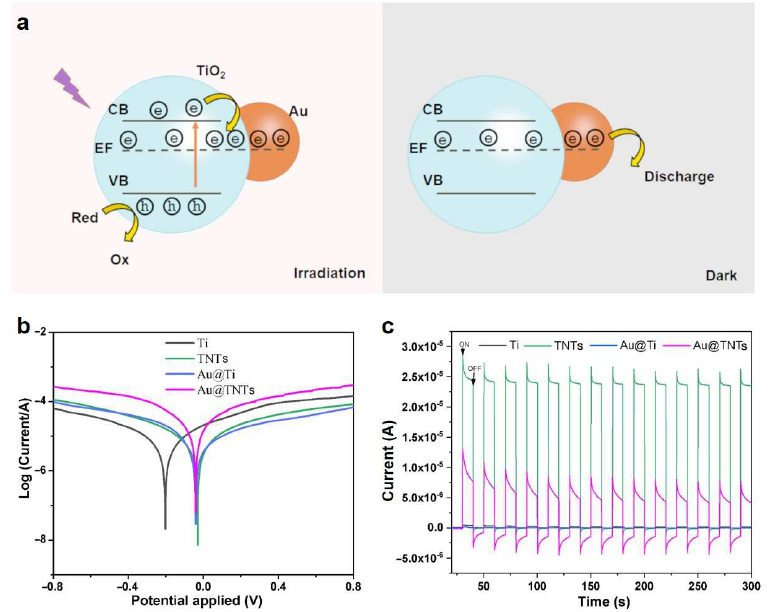
Figure 5. Schematic diagram for the photocatalytic memory effect of Au@TNTs samples ( a ). Tafel curves ( b ) and photocurrent curves ( c ) of various samples.